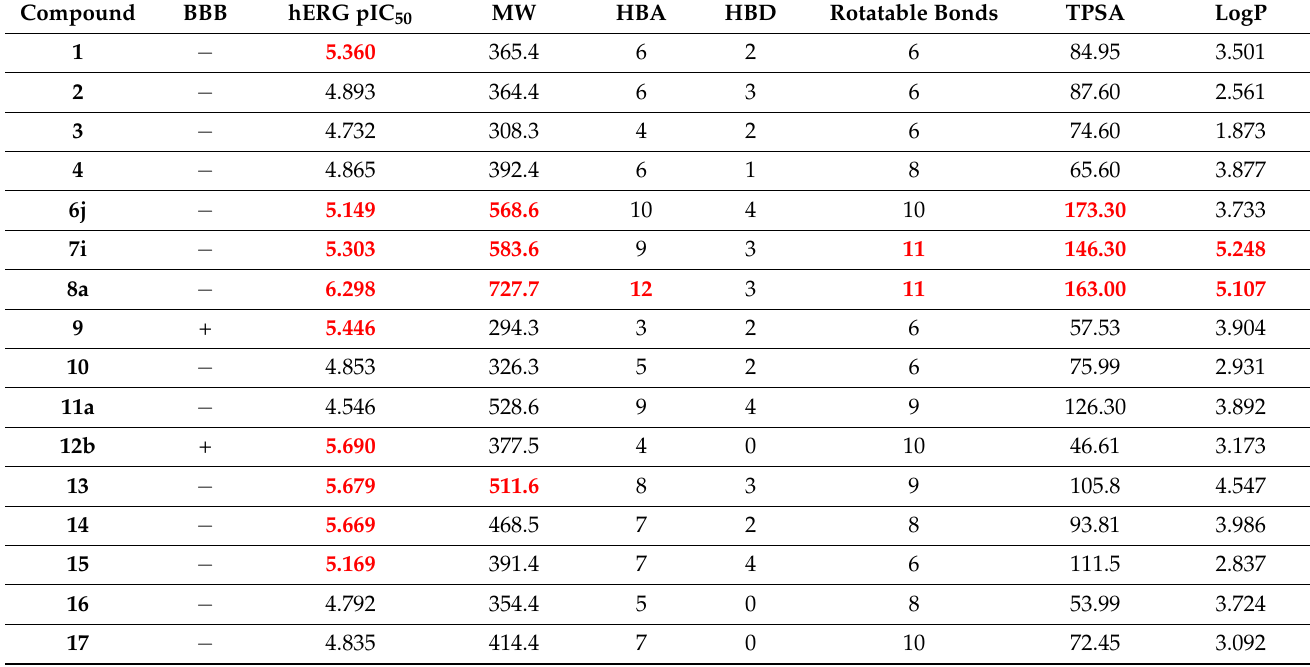
Table 4. ADME and drug-like properties of potential curcumin conjugates and curcumin mimic conjugates (Bold red numbers: Indicates violation of recommended key drug-like